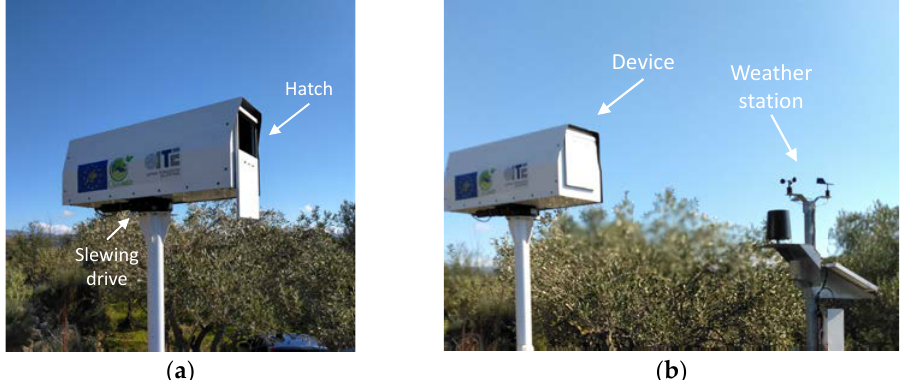
Figure 6. Image ( a ) of the device with ( b ) the weather station installed in Kato Valsamonero, Crete, Greece.